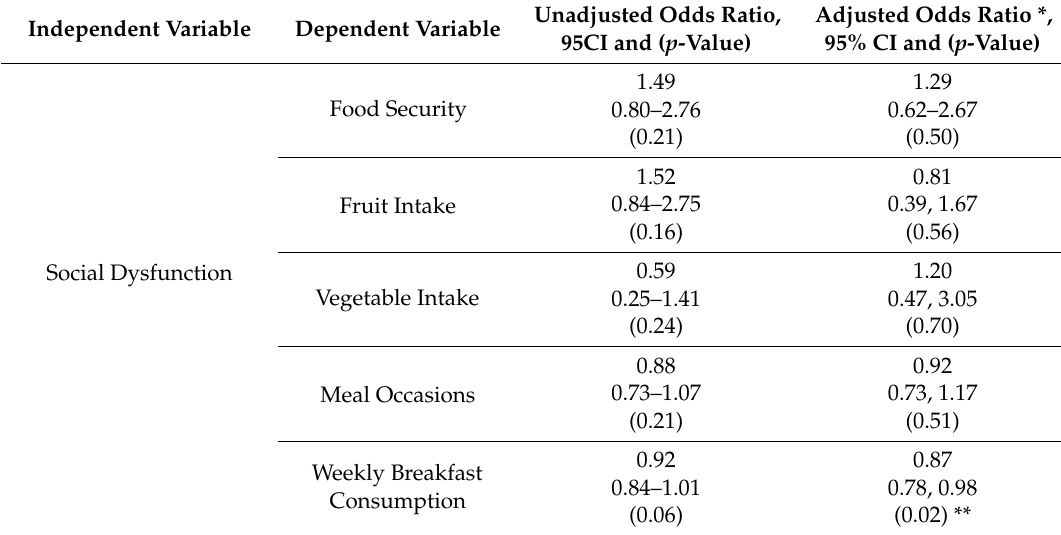
Table 2. Binary Logistic Regressions for Social Dysfunction and Food Security, Fruit Intake, Vegetable Intake, Meal Occasions and Weekly Breakfast